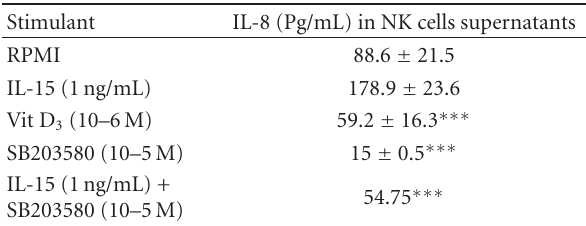
Table 1: Amount of IL-8 recovered in supernatants of NK cells after 72 h culture